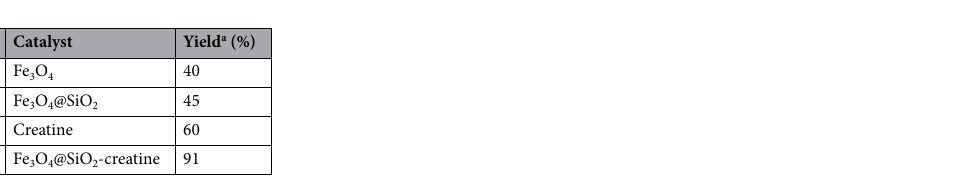
Table 2. Comparison of catalytic activity of the prepared catalyst with the substrates alone. a Isolated